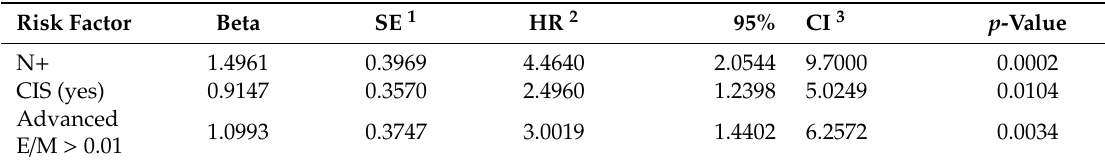
Table 3. Cox regression model for disease-free survival. The model includes the most contributive clinicopathological variables (see Appendix A Table A1) and the binarized E / M score. Risk Factor Beta SE 1 HR